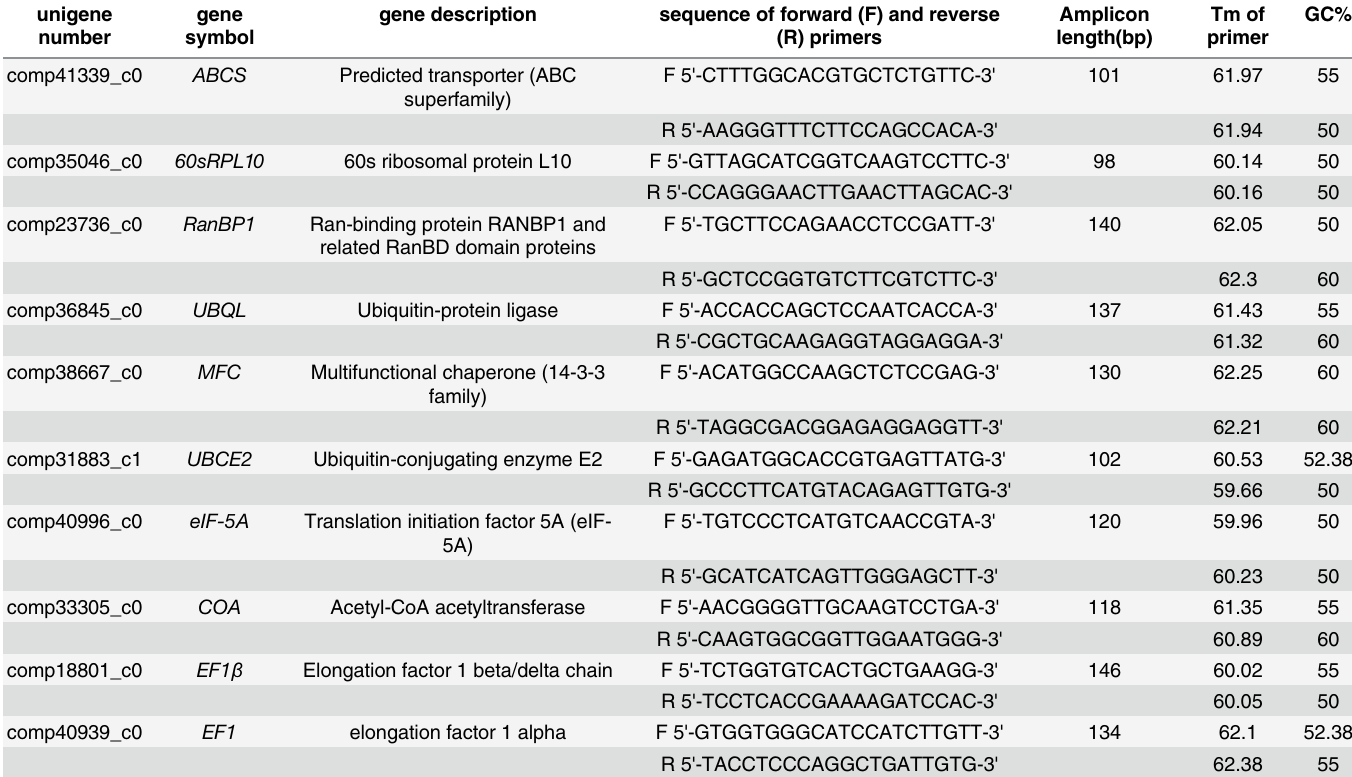
Table 2. The primer description of 10 candidate RGs evaluated in this study. unigene number